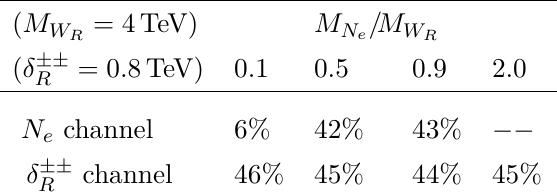
Table 2. The overall efficiency of the detector and the event selection criteria of the signal ( N e and δ ±± mediated channels) for different values of M N R